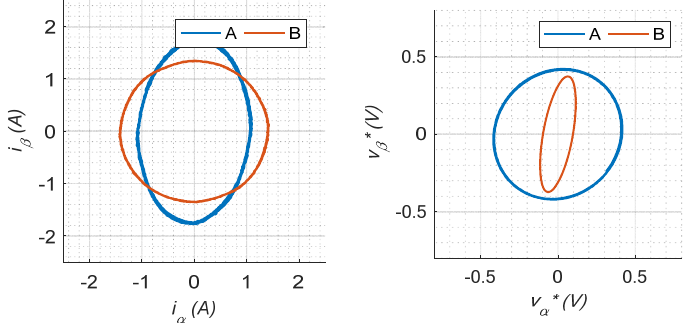
current of set 2.